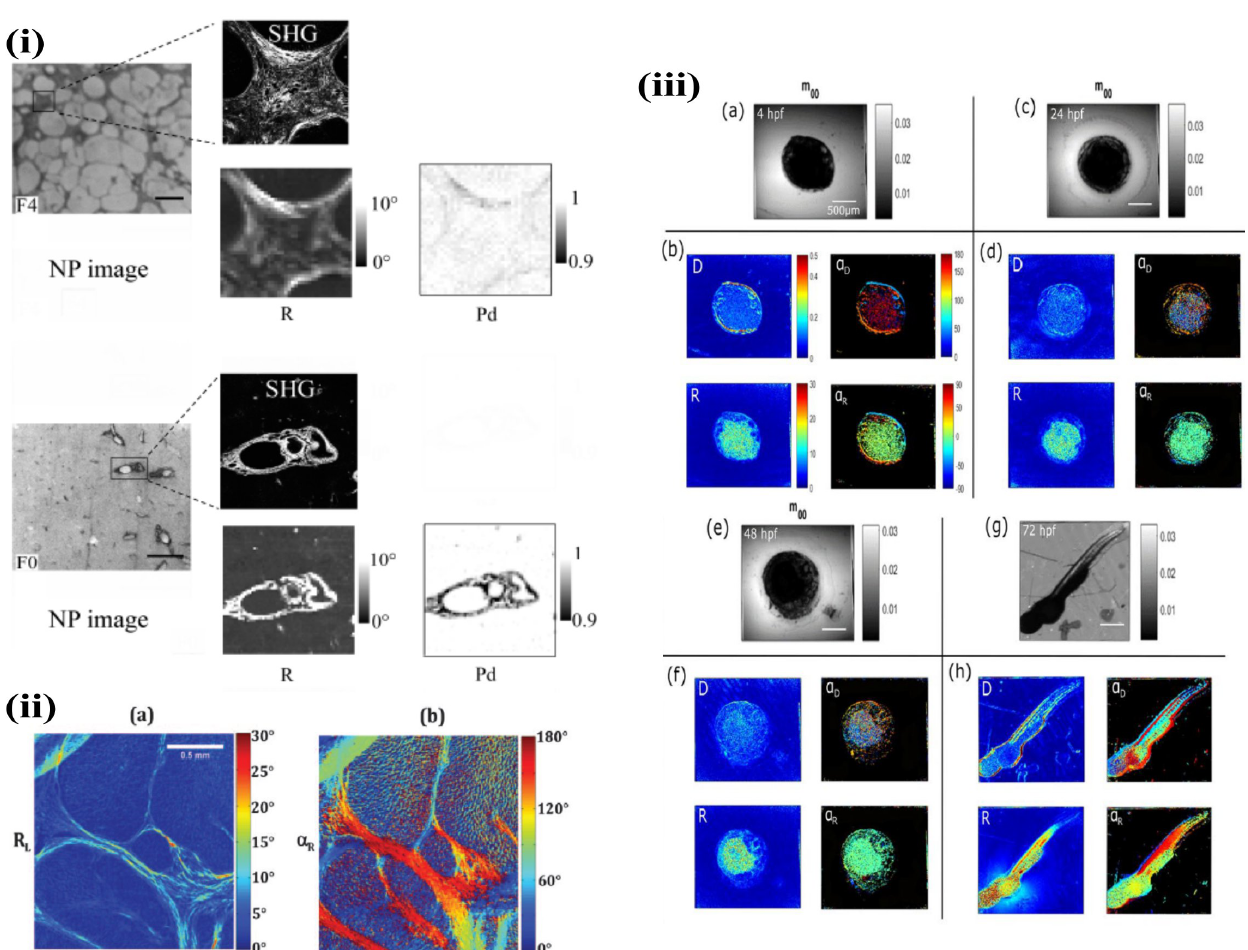
Figure 6. Quantitative imaging of the full MM images for biomedical diagnosis. ( i ) Non-Polarized (NP), SHG, Retardance (R) and depolarization index (Pd) images of stained surgical human liver biopsies (F0 and F4 Metavir grades). ( ii ) Retardance (R) and its orientation ( α R ) image of a human liver biopsy. ( ii i) Polarimetric images of fixed zebrafish embryos and larvae at 4 hpf (hours post fertilization), 24 hpf, 48 hpf and 72 hpf. The images (a), (c), (e), (g) correspond to the total collected intensity from the MM, which is the m00 element. The images (b), (d), (f), (h) are images coded in Diattenuation (D), in Retardance and its azimuthal orientations α D